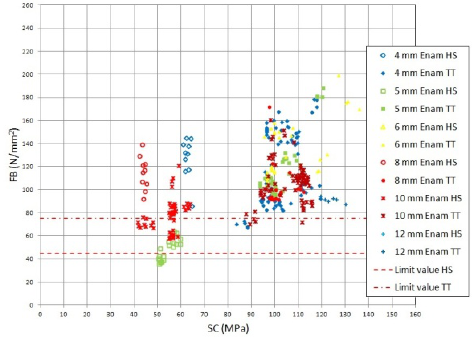
Fig. 8. Correlation of surface compressive stress (SC) versus flexural bending (FB) for enamelled glass. The limit value of SC that has to be reached to respect the characteristic strength value of thermally toughened (TT) safety glass can be fixed 90 MPa for float and B1 glass and 95 MPa for other coated glass and enamelled glass (Tab. 9), having in such way a very low incidence of NC